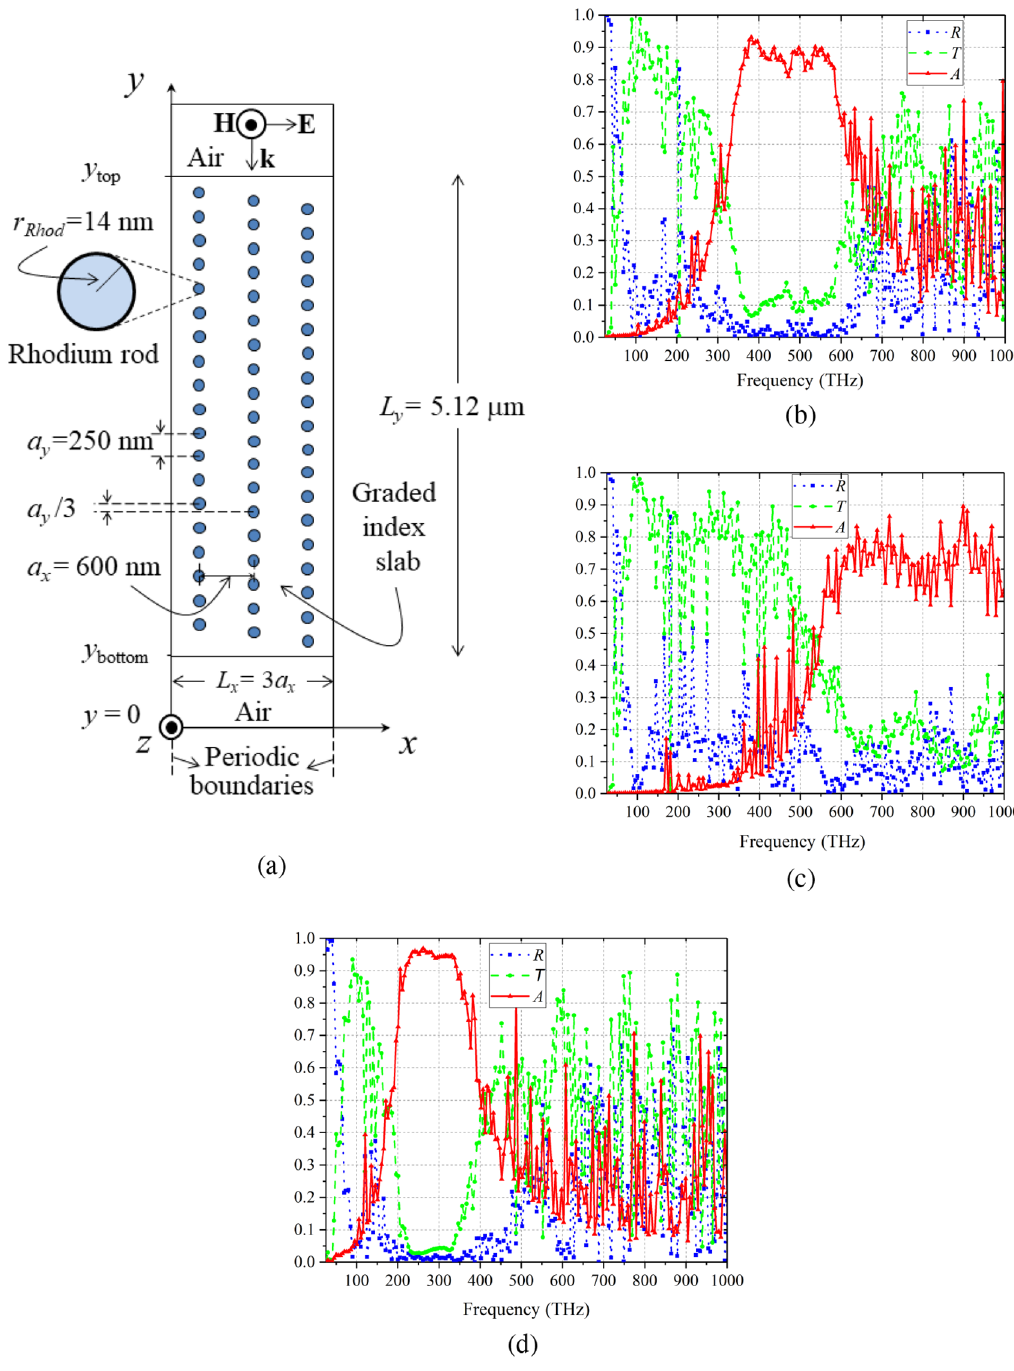
Fig. 3. (a) Schematic diagram (not according to scale) of the unit cell for a structure consisting of the graded index dielectric slab shown in Figure 2b, with three columns of rhodium rods embedded in it. Each rod has radius r =14nm, and the rods are separated horizontally by a x = 600nm and vertically by a y = 250nm. (b – d) Numerically calculated R , T , and A spectra for TM normal incidence on the structure shown in (a), with metal rods consisting of: rhodium of radius 14 nm in (b), tungsten of radius 8 nm in (c), and TiN of radius 24 nm in